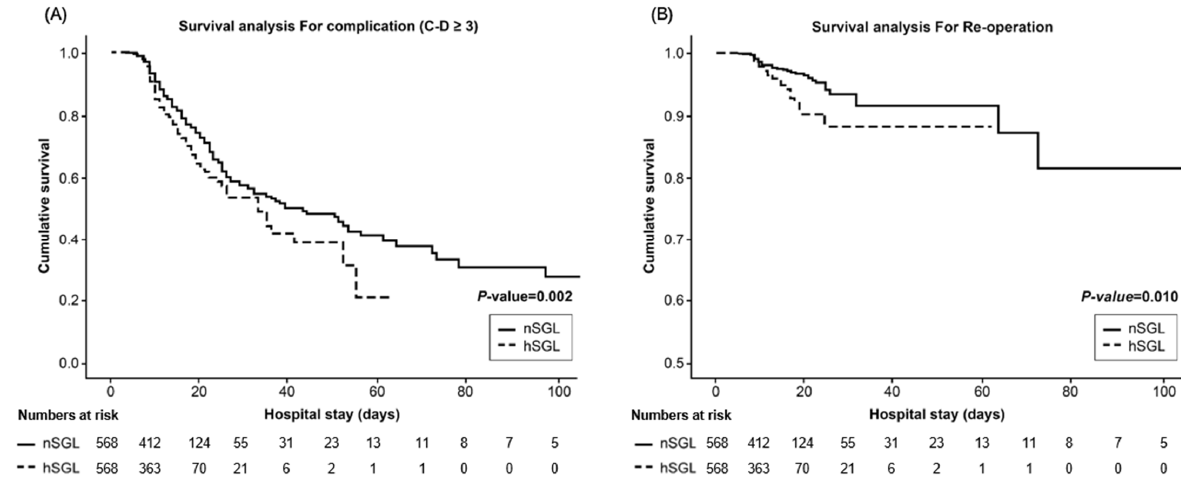
Figure 2. Cumulative major complications ( A ) and re-operations ( B ) estimated using the Kaplan–Meier method. The risk factor analysis for major complications used logistic regression models (Ta- Table 3. Logistic regression for risk factor analysis of major ble 3). We selected variables that were universal risk factors of major complication and main outcomes of this study. Being male (hazard ratio [HR] = 1.439, 95% confidence inter-